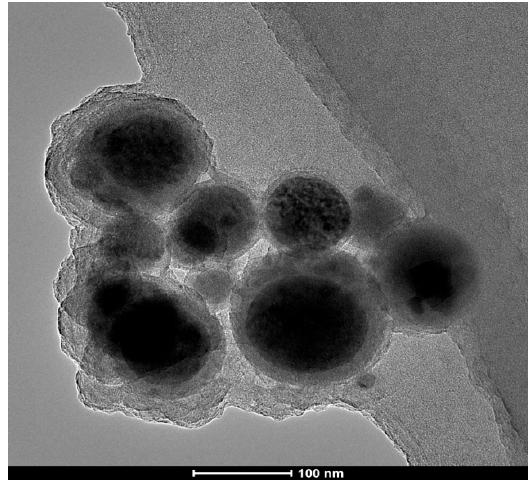
Figure 8. Transmission electron microscope image of nano − ethylene glycol titanium catalyst.